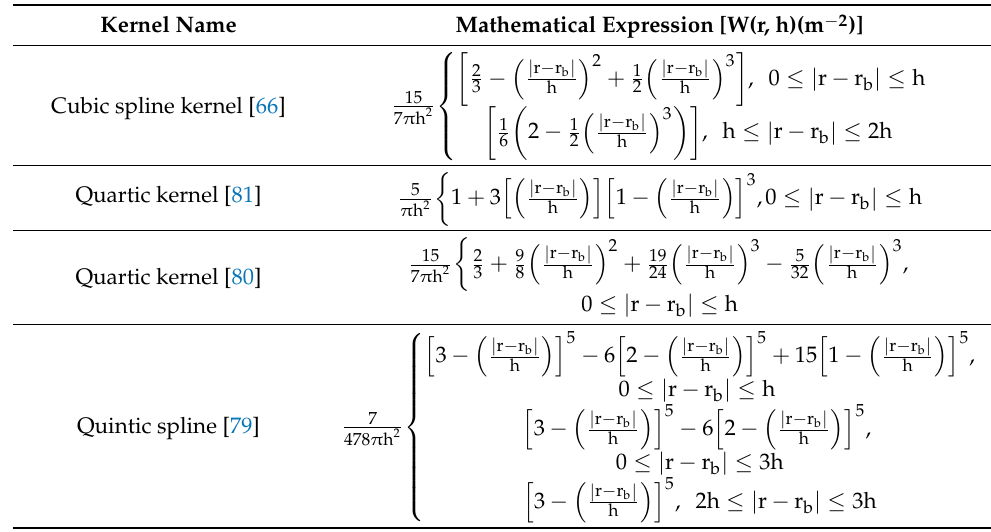
Table 3. Typical interpolation kernels used for SPH